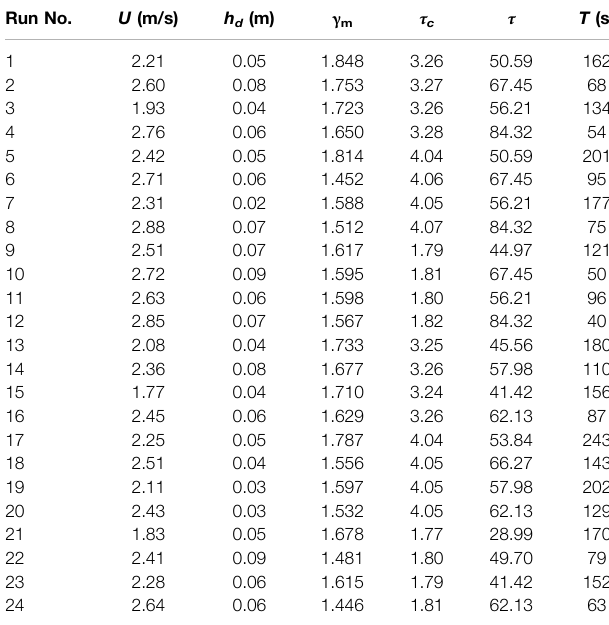
Note , The green-shaded cells indicate that partical mode of dam failure induced debris fl ow occurred in these experimental runs, whereas other runs in non-shaded cells are associated with en masse failure